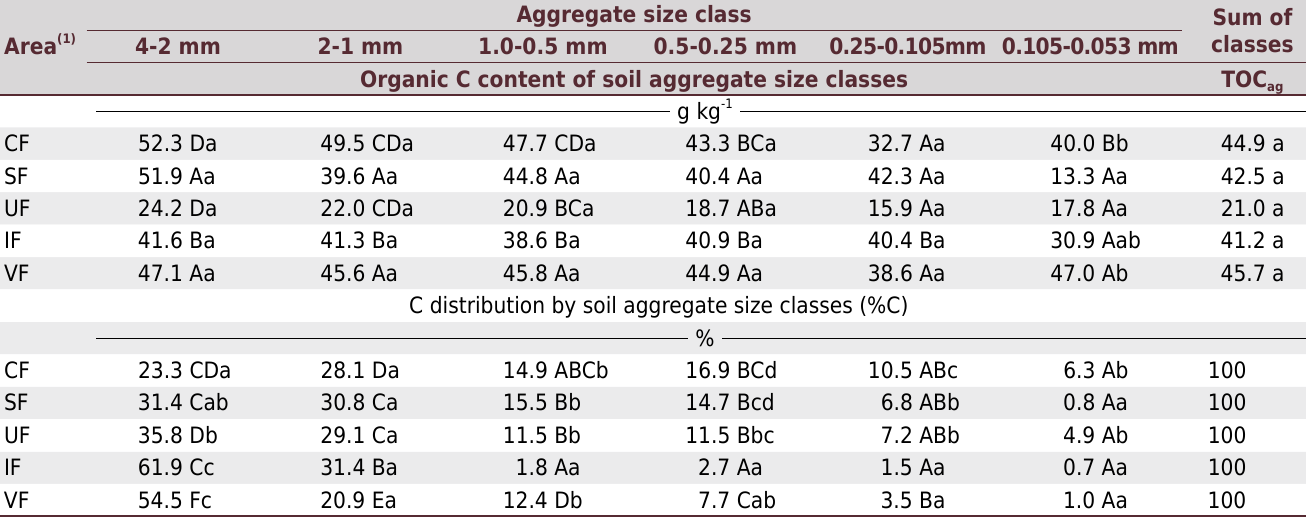
Table 7. Organic C content of aggregate size classes; C distribution by aggregate size classes (%C - expressed on an equivalent soil mass basis), and sum of organic C of soil aggregates (TOC ag - expressed on an equivalent soil mass basis), in different forest areas, 0.00-0.08 m soil layer Area